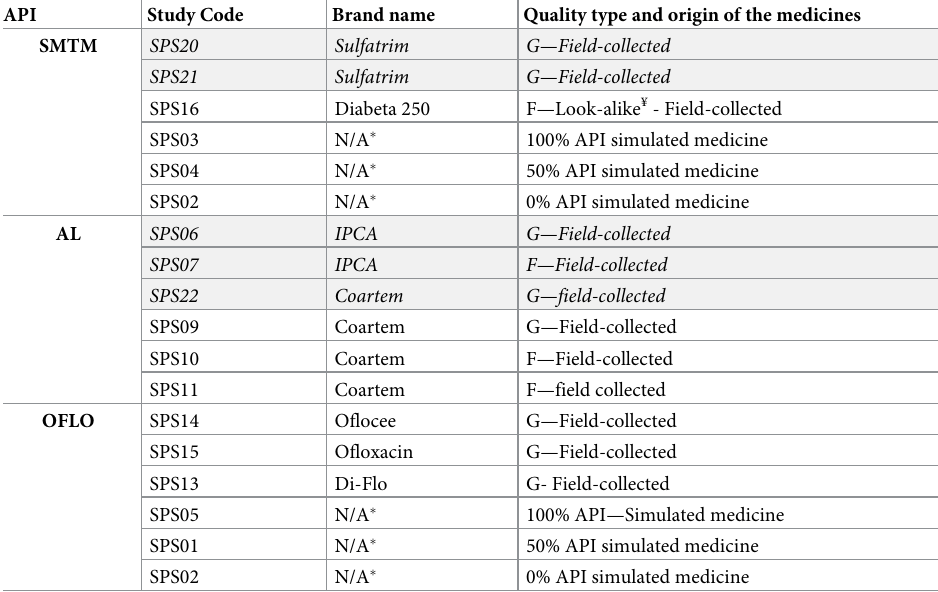
Table 2. Samples sets of medicines initially included in sample set